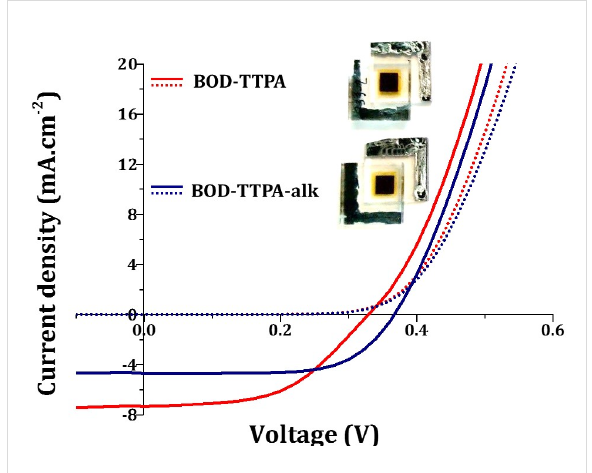
Figure 6: J (V) curves of the best performing DSSCs devices sensi- tized with compounds BOD-TTPA-alk (blue traces) and BOD-TTPA (red traces) in dark (dashed lines) and under AM1.5G conditions (solid lines). Light source: AM1.5G at 100 mW·cm − 2 , electrolyte composition: 0.5 M of BMII, 0.03 M of I 2 , 0.5 M of LiI, 0.1 M of guanidinium thio- cyanate in a mixture of acetonitrile and 3-methoxyproprionitrile (85:15, v/v), electrodes: 12 µm mesoporous anatase TiO 2 + 4 µm TiO 2 scat- tering layer, dyeing bath: [Dye] = 0.2 mM, [CDCA] = 2 mM in CHCl 3 / EtOH 1:1